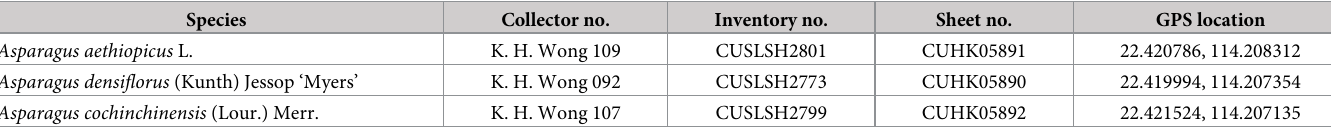
Table 1. Information about the Asparagus specimens deposited at the Shiu-Ying Hu Herbarium. Species Collector no. Inventory no. Sheet no. GPS